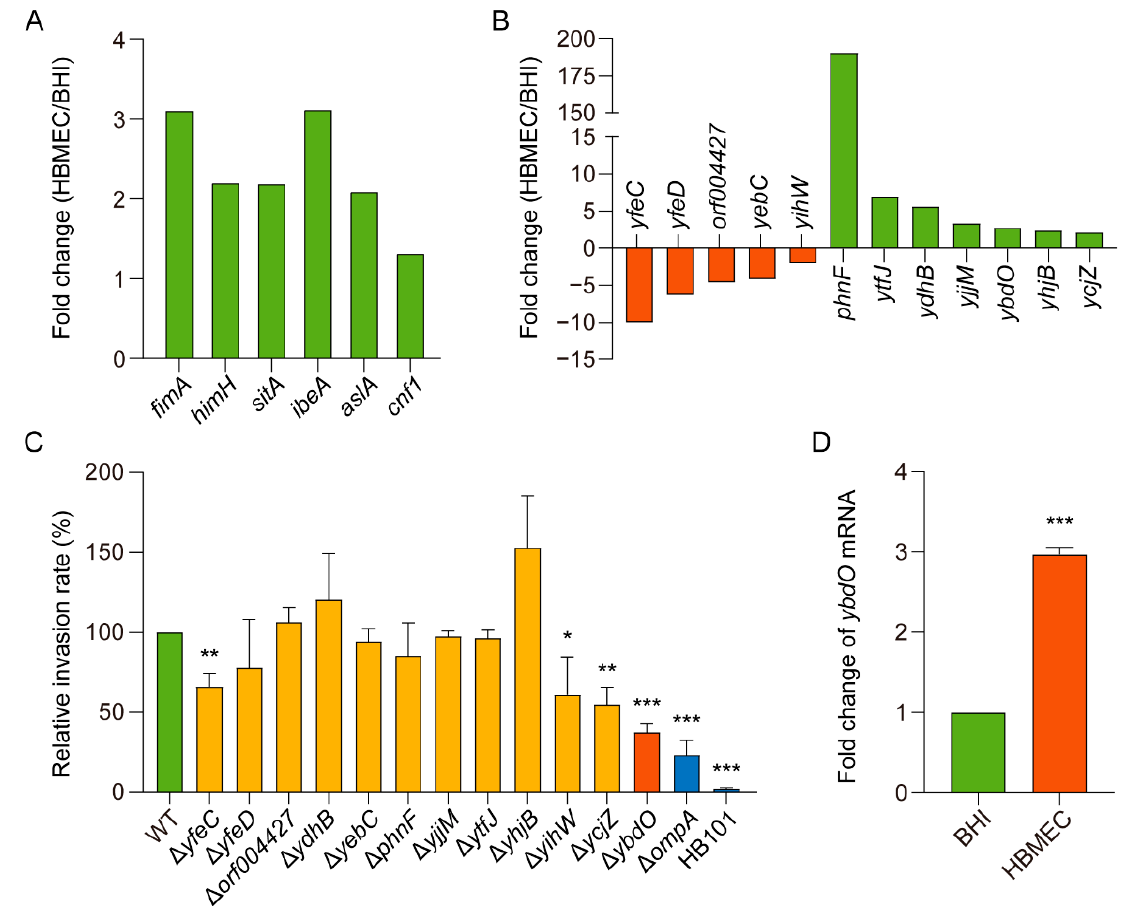
Figure 1. Significant upregulation of ybdO expression following E. coli K1 invasion of HBMECs. ( A ) Fold change in the fragments per kilobase of transcript per million fragments mapped (FPKM) of representative differentially expressed toxic genes. ( B ) Fold change in the FPKM of putative transcriptional regulators. ( C ) Mutation of putative transcriptional regulators revealed their different roles in HBMEC invasion. ( D ) To validate RNA-seq results, ybdO expression was analyzed by qRT- PCR. Data were obtained from three independent experiments and analyzed using Student’s t -test. * p < 0.05, ** p < 0.01, *** p < 0.001.